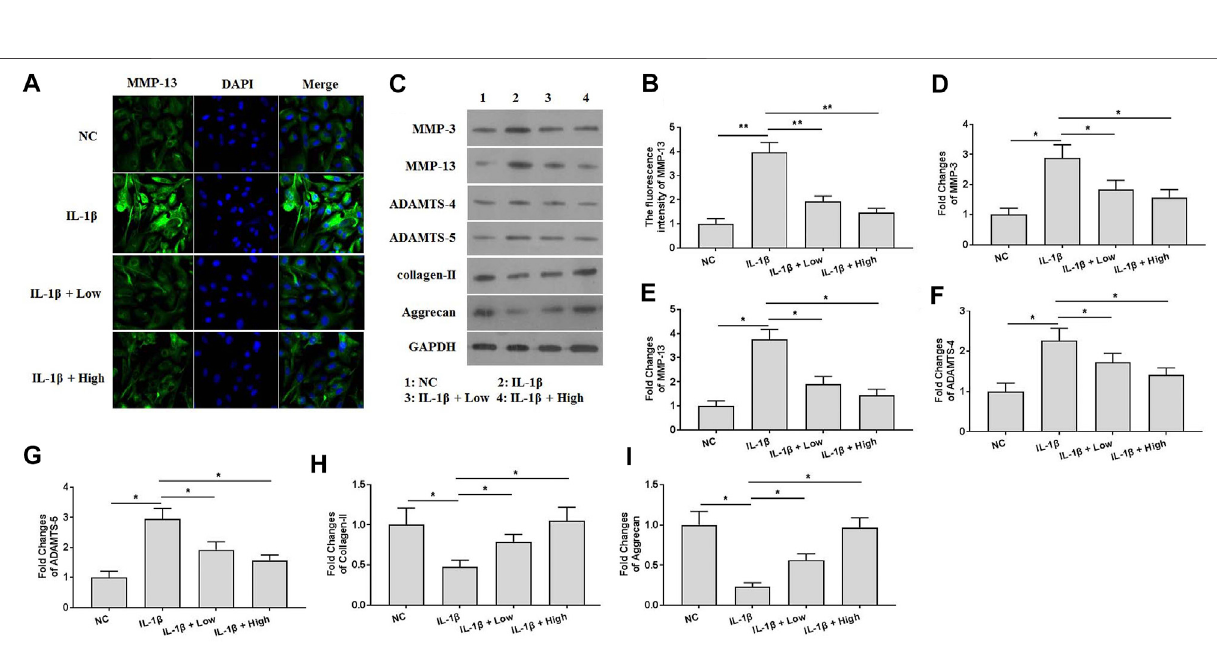
Frontiers in Pharmacology |